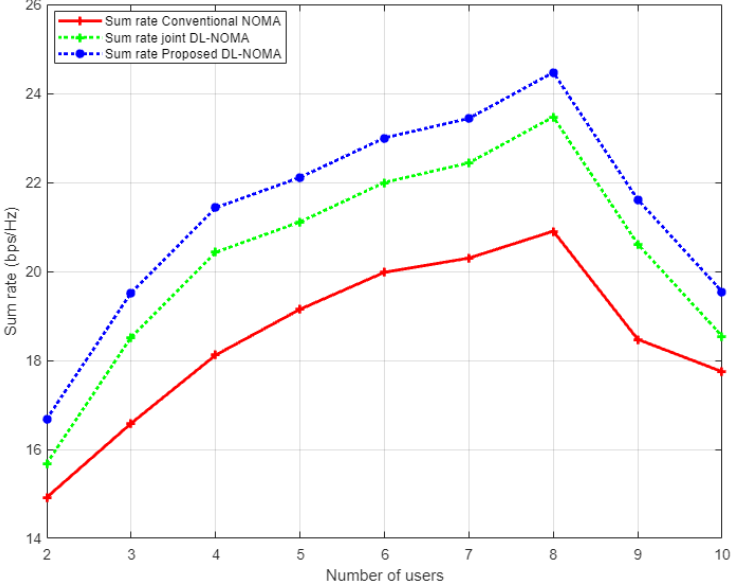
Figure 11. Sum rate vs. number of users for conventional NOMA, joint DL-NOMA, and the proposed DL-NOMA (Rayleigh